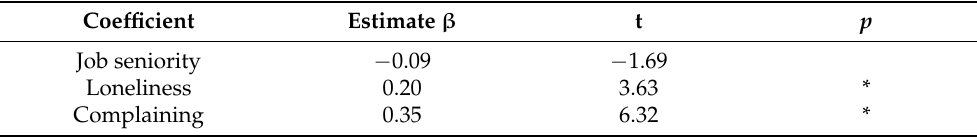
Table 2. Regression model for the exhaustion variable with significant predictors in the group of employees of psychiatric wards. Coefficient Estimate β t p Job seniority − 0.09 − 1.69 Loneliness 0.20 3.63 * Complaining 0.35 6.32 *